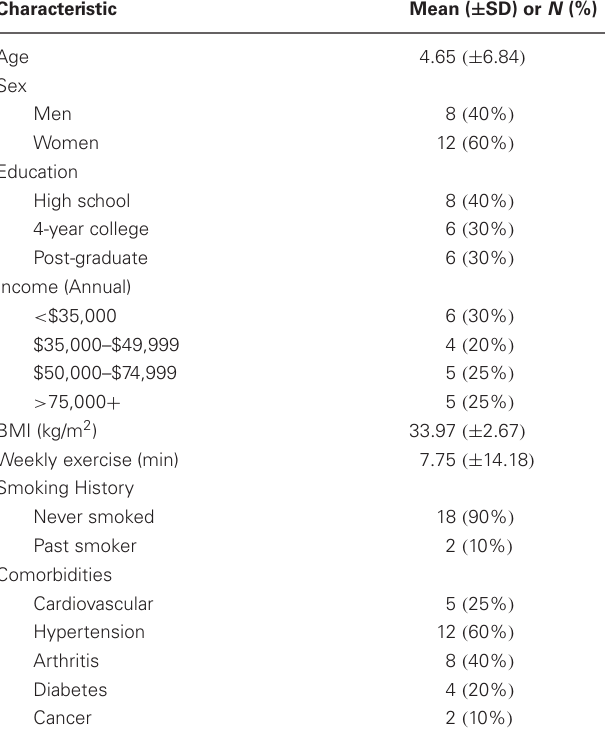
Table 1 | Descriptive characteristics of participants.